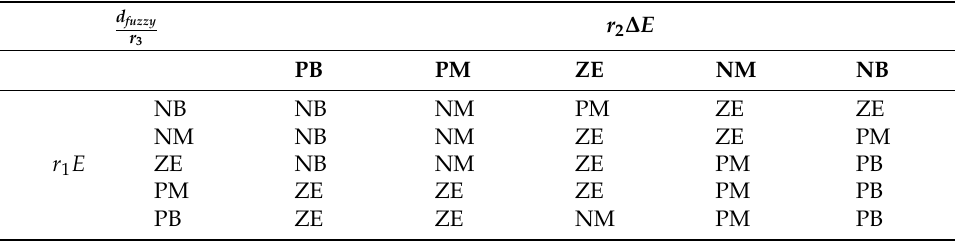
Figure 2. Membership functions of the input and output of the fuzzy system. Table 2. Rules of the Fuzzy